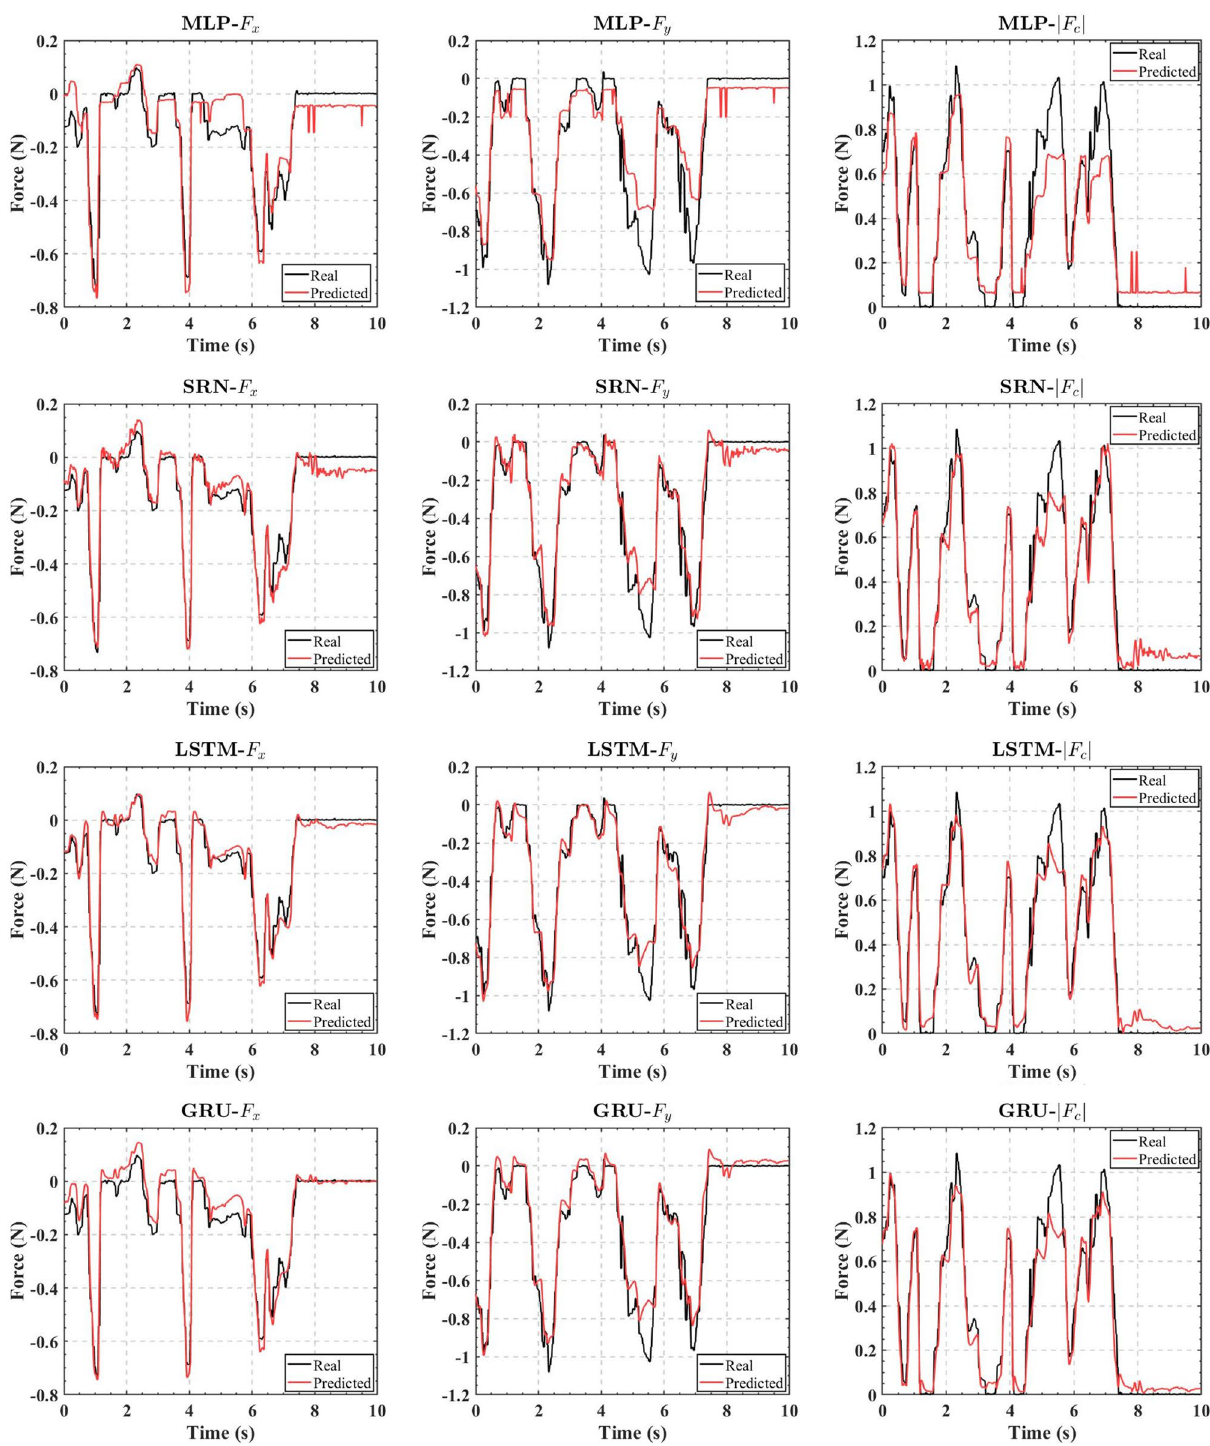
Figure 6. Accuracy of the ANN-based estimators for F x , F y and | F c |